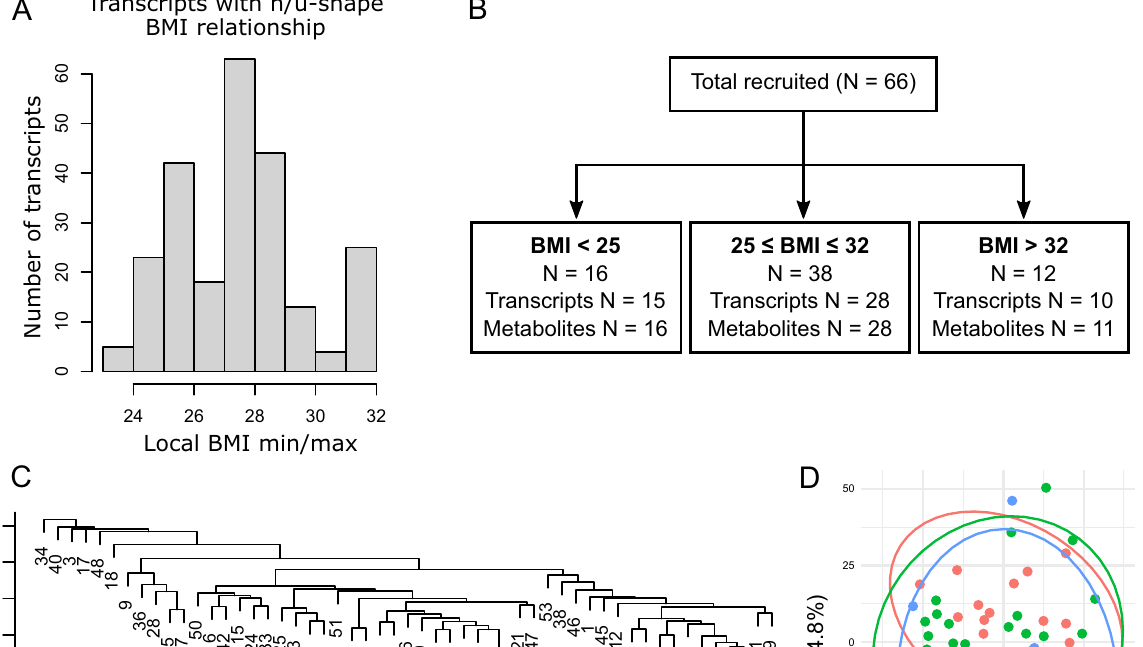
and displaying biphasic BMI dependence are plotted in Figure S1. These include CARS1 (translation), UPF3A, PPP2R1A (nonsense-mediated decay), NHP2, THUMPD1 (rRNA processing), IGKV2-28, FCN3 (creation of C4 and C2 activators), OAS3 (interferon signaling), KYAT3, RSAD2 (metabolism of amino acids) and TNNT2 (striated muscle contraction).